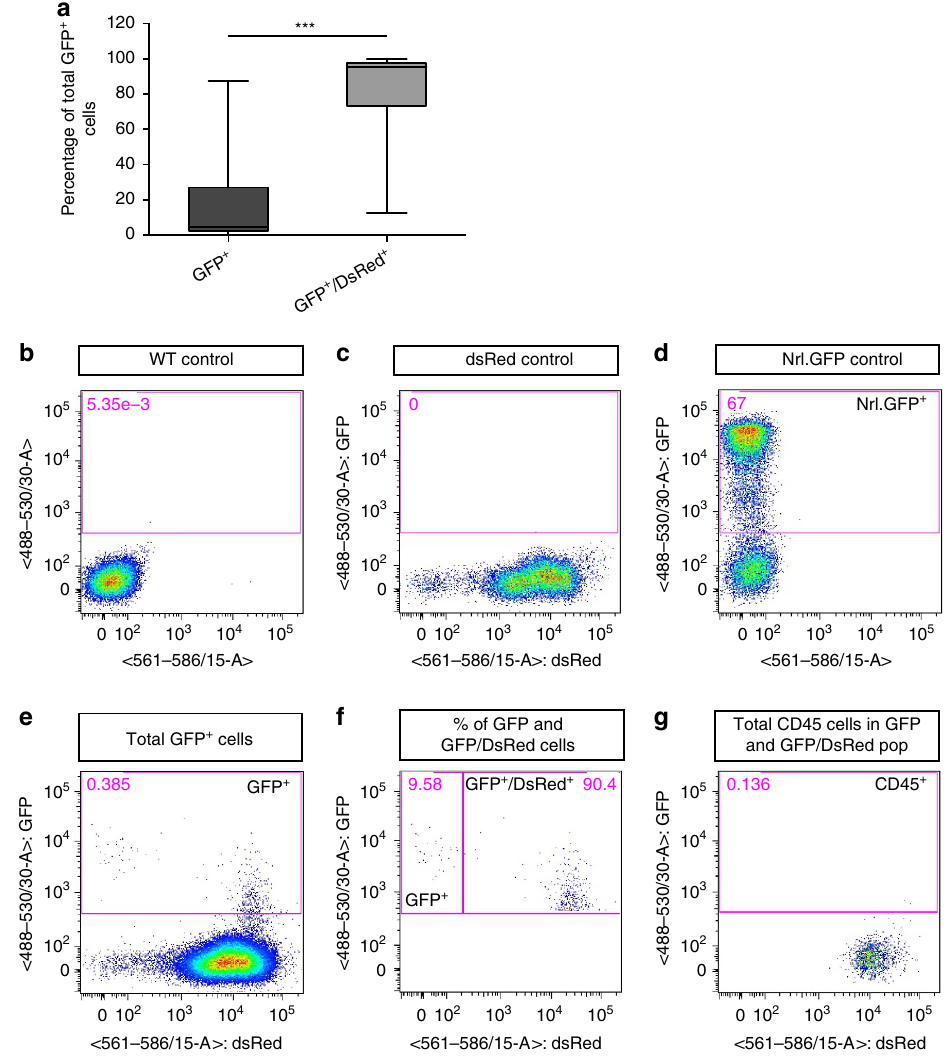
Figure 3 | Host and donor photoreceptors exchange fluorescent reporter proteins as determined by flow cytometry. NrlGFP post-mitotic photoreceptor precursor donor cells were transplanted into DsRed hosts and examined by flow cytometry 5-6 weeks post transplantation. ( a ), box (25–75% percentile) and whiskers ( min /max) plot showing median (line) % of GFP þ only and GFP þ /DsRed þ photoreceptors within each host retina ( N ¼ 18 retinae). *** P o 0.001, paired t -test. ( b – d ), representative flow cytometry plots for adult ( b ) wild-type (negative control), ( c ) DsRed (positive control) and ( d ) NrlGFP (positive control) retinae. Pink box shows gating for GFP þ cells. ( e , f ), representative plots from an example of a host retina showing ( e ) % of total retinal cells that were GFP þ ( pink box ) and ( f ) the proportion of these that were GFP þ only ( left pink box ) or GFP þ /DsRed þ ( right pink box ). ( g ), plot showing the proportion of CD45 þ cells within the GFP þ population shown in ( e , f